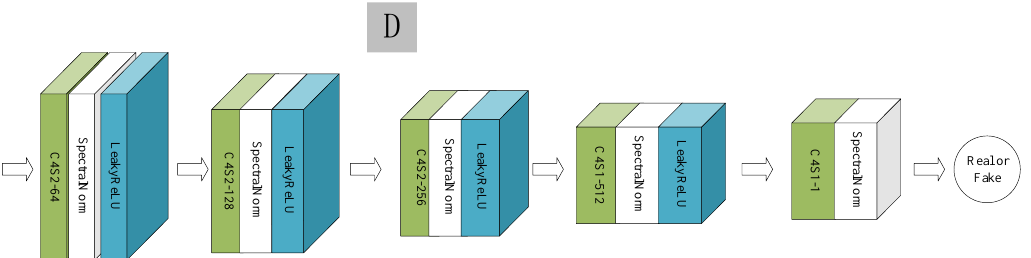
Figure 4. Structure of the discriminator. Here, C4S2-64 denotes a convolutional layer with a kernel size of 4, channel number of 64, and stride of 2.